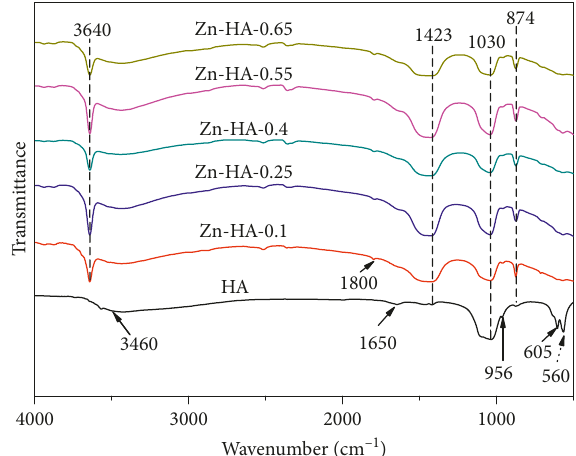
Figure 4: FTIR spectra for HA and Zn-HA samples with different Zn content.